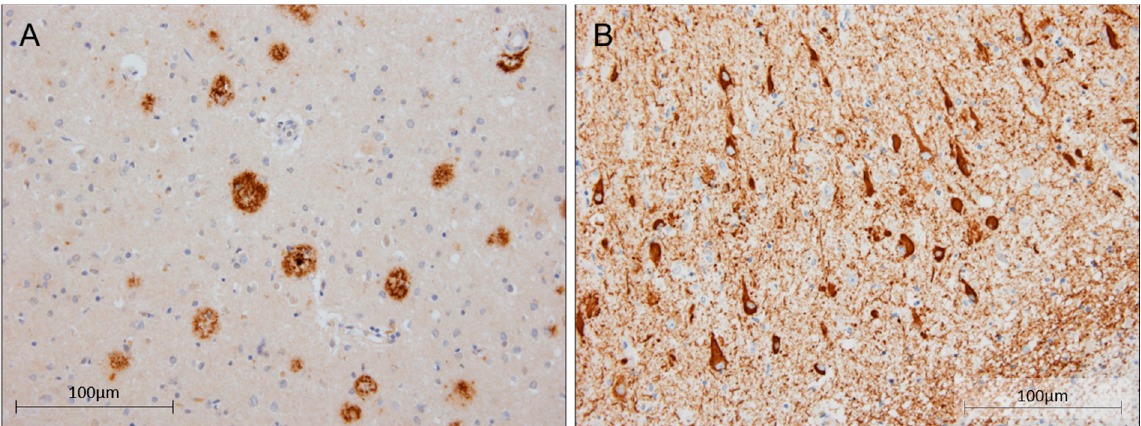
Figure 4. Post-mortem brain tissue from case 4. ( A ) Immunohistochemistry (IHC) staining of β -am- yloid in parietal association cortex configuring amyloid plaques (20×). ( B ) Intense IHC staining of tau in the cortex of the middle temporal gyrus (20×). Scalebar: 100 μ m.